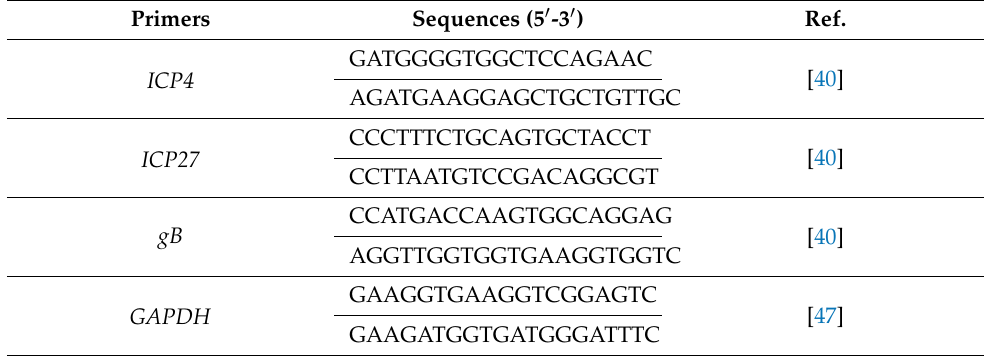
Table 3. Sequence of primers used in the real-time PCR